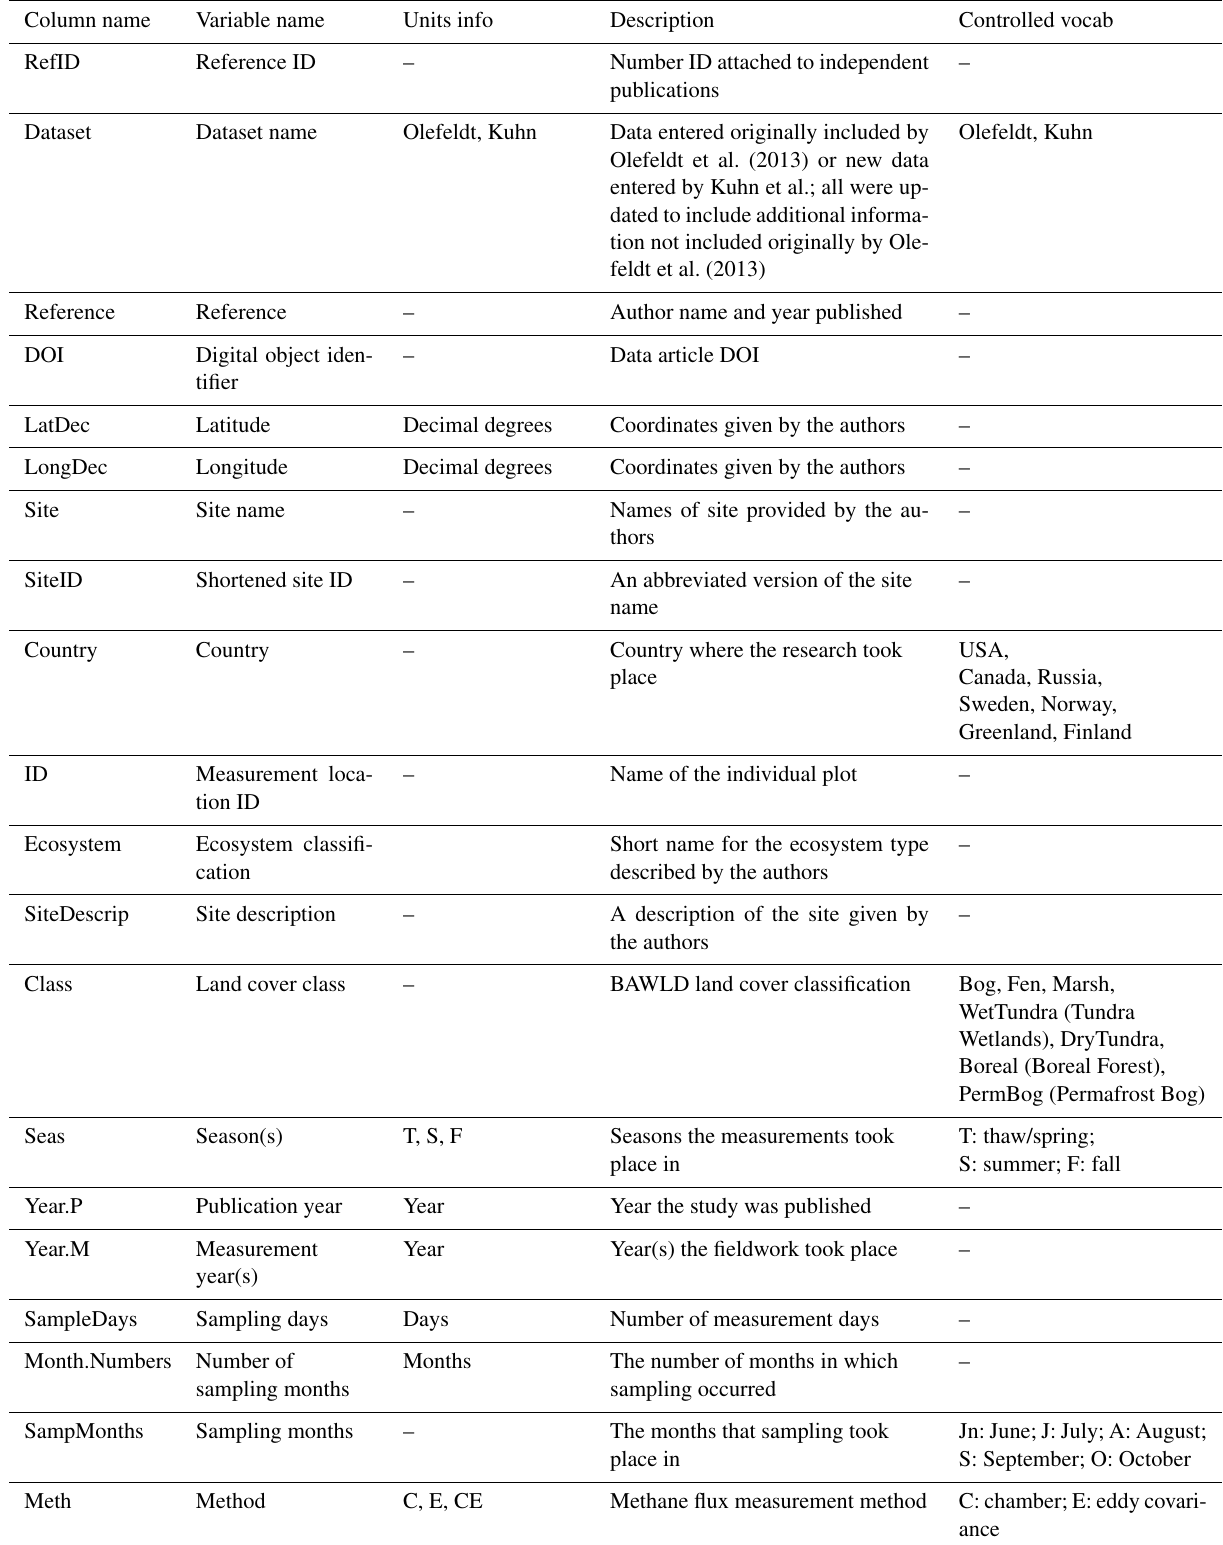
Table 1. Attribute information for the terrestrial flux